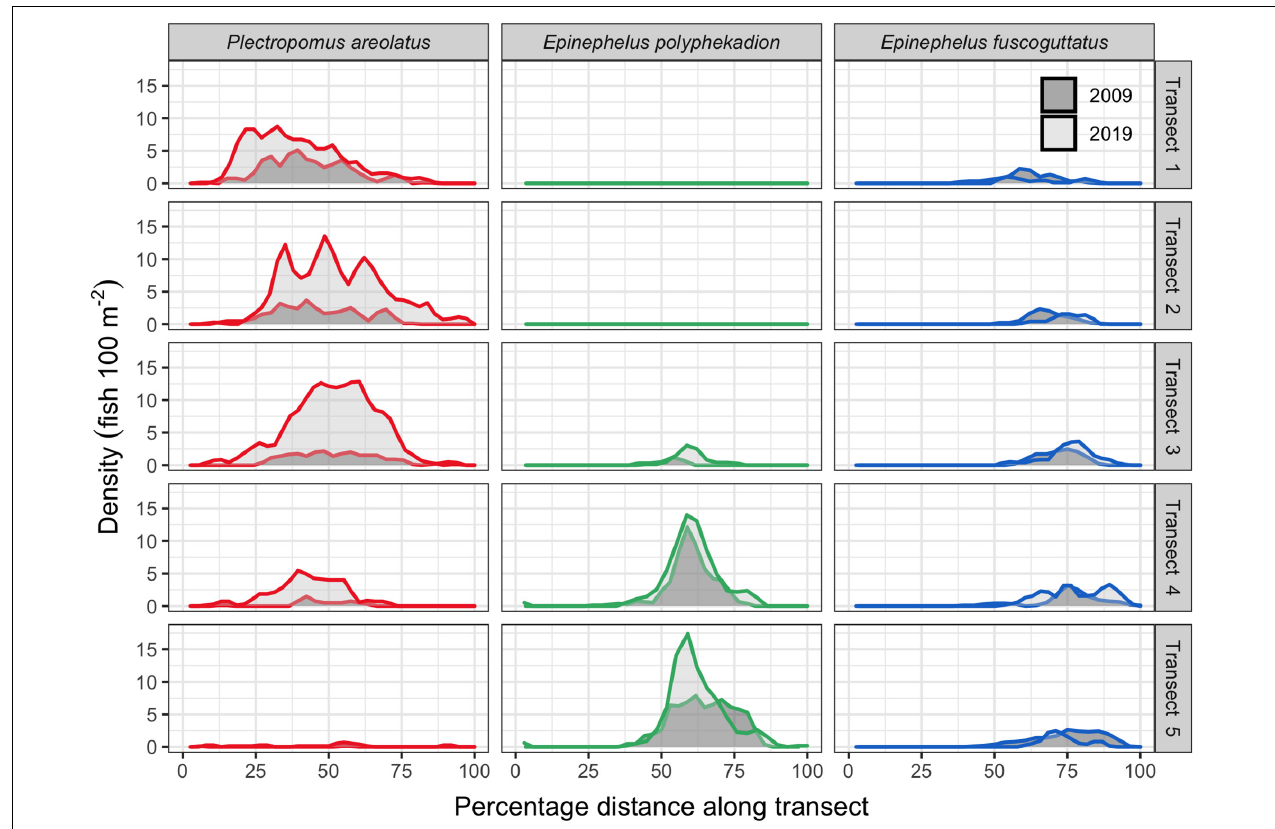
FIGURE 7 | Fish density across the 5 survey transects by species for 2009 and 2019 with only days of annual peak abundances shown. Each row is a separate transect with transect 1 being the shallowest (8–12 m) and transect 5 the deepest (23–27 m). Densities for each species are shown relative to their location along each transect as a percentage of the distance from the start (0) to the end (100). Transect length is about 650 m and swath width of 20 m; direction is from the outer reef toward the lagoon ( Figure 1